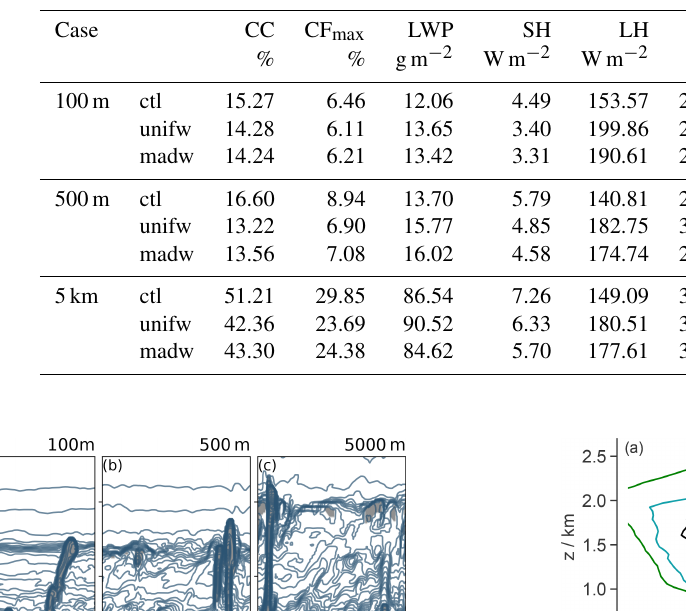
Figure 3. Profiles of second-day domain-averaged (a) potential temperature θ , (b) total water specific humidity q t , (c) RH, (d) cloud water q c and (e) cloud fraction (CF) for different horizontal resolutions of the ctl (solid lines) and ctl-P simulations (dotted lines). Table 2. Averages of total cloud cover (CC), maximum vertical cloud fraction (CF max ), liquid water path (LWP), surface sensible heat flux (SH), surface latent heat flux (LH), inversion height ( z i , representing the location of maximum θ gradients), cloud base height ( z b , representing the minimum height where 50% of CF max is reached) and change in the shortwave cloud radiative effect ( (cid:49) SWCRE) at 100m, 500m and 5km resolutions in the non-precipitating simulations of the ctl, unifw and madw climate states.